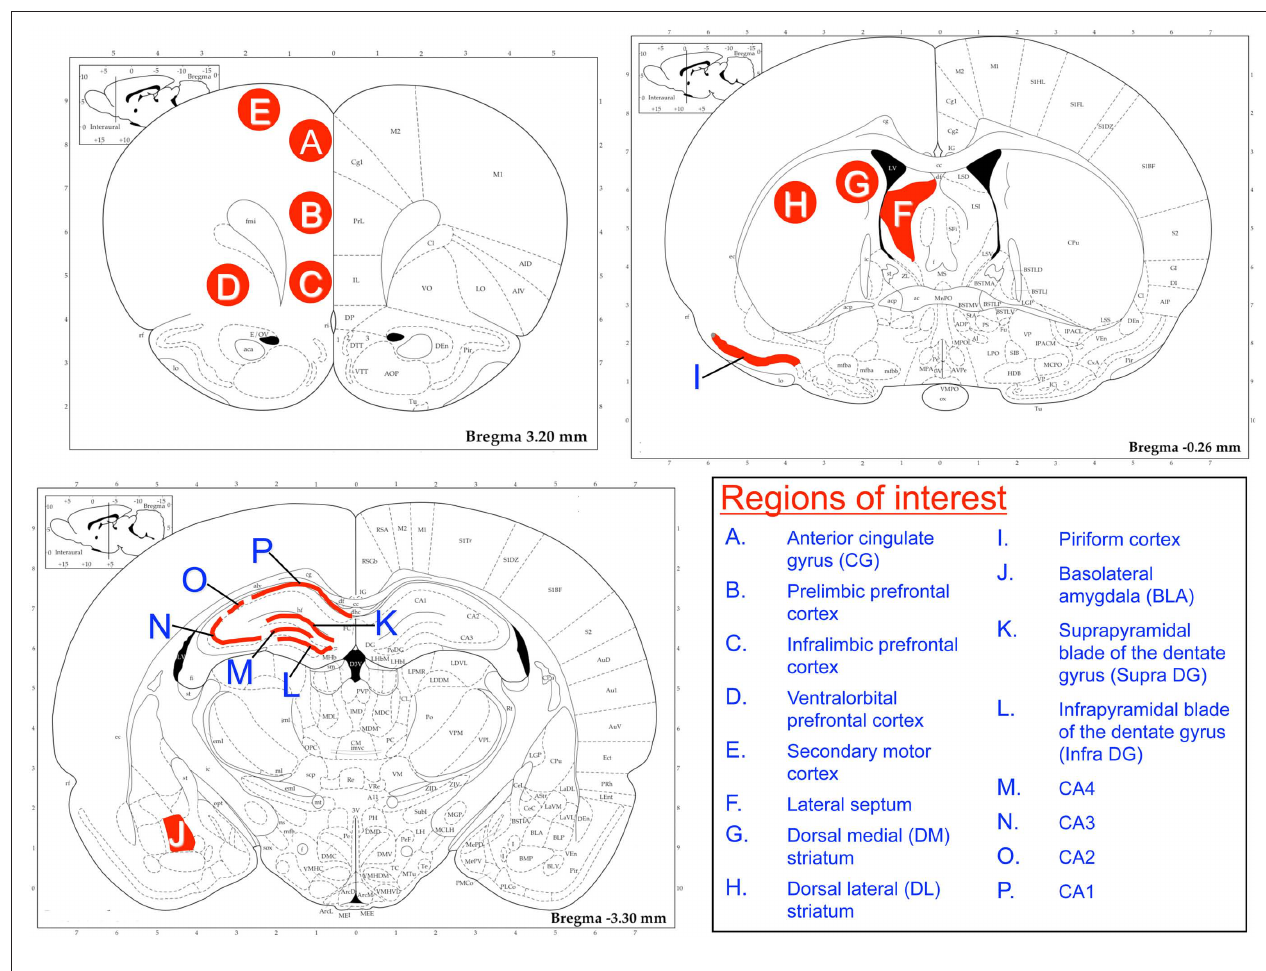
ROIs were overlaid on digitized autoradiographic images as shown. Lines illustrate an outline over the principle cell layer of the piriform cortex and hippocampal subregions; the septum and amygdala were outlined according to their shape in the Rat Brain Atlas (Paxinos and Watson, 1998), and circles were centered within the